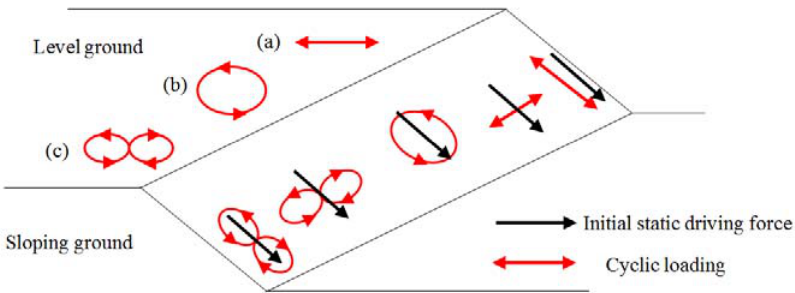
Figure 7. Multi ‐ directional loadings considered the initial static driving force, tested by Kammerer (Reprinted from [37]).